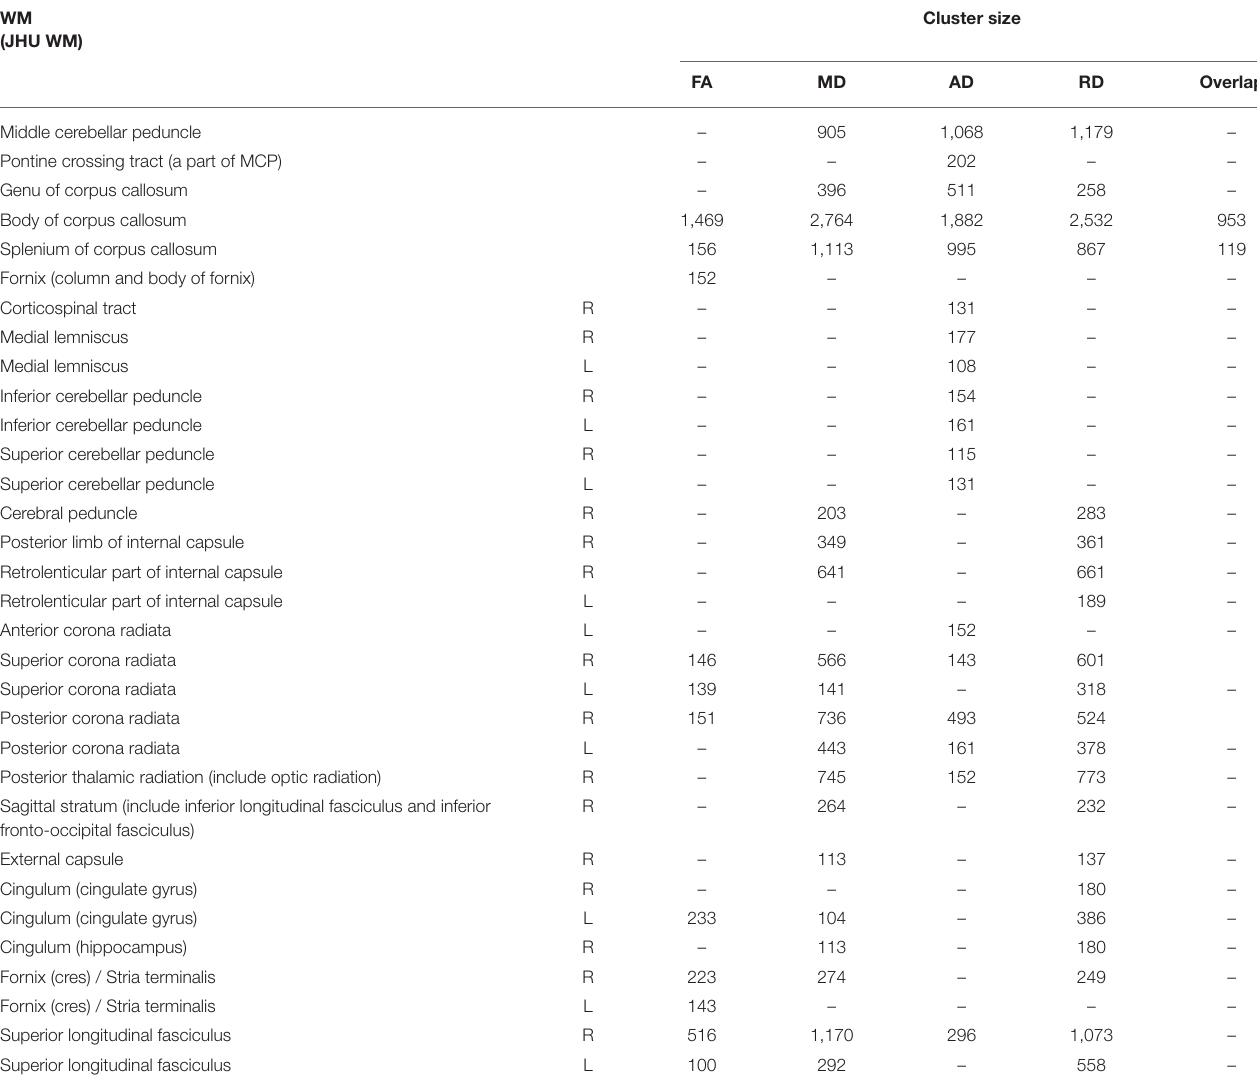
TABLE 2 | Regions with significantly increased FA and decreased MD, AD, and RD in patients with KOA. WM (JHU